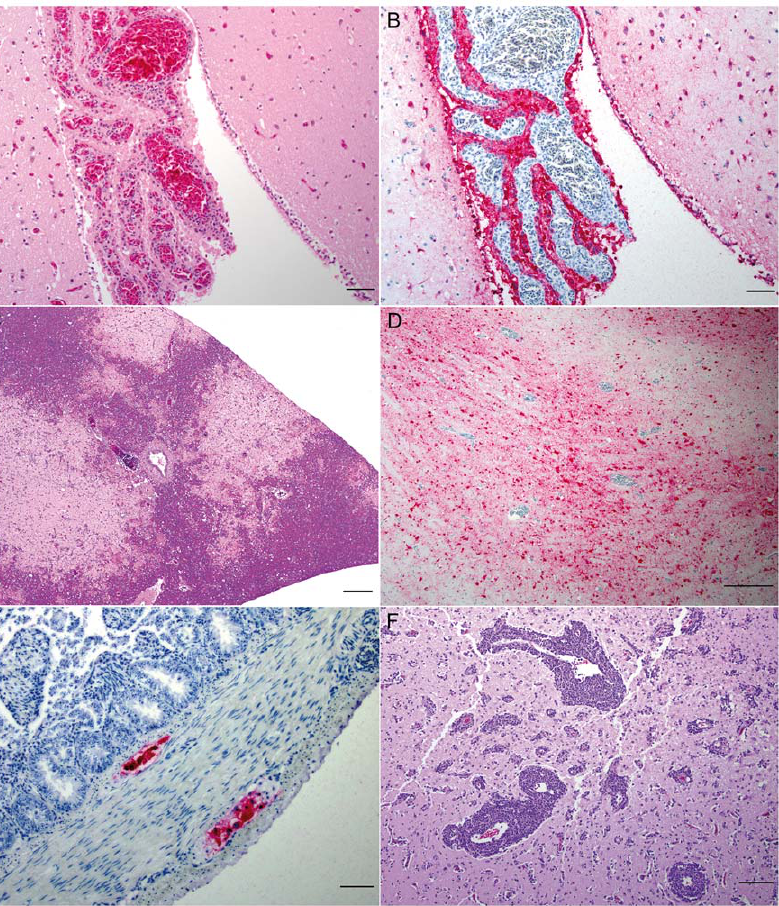
Figure 1. Histopathology and immunohistochemistry of different tissues from wood ducks ( Aixsponsa ) infected with A/whooper swan/Mongolia/244/05 (H5N1). (A) Brain, Choroid Plexus; wood duck that succumbed to Mongolia/05 virus infection. Severe choroiditis characterized by necrosis of epithelial cells of choroid plexus, vasculitis and heterophilic infiltrate. Hematoxylin-eosin staining. Bar 50 m m. (B) Brain, Choroid Plexus; wood duck that succumbed to Mongolia/05 virus infection. Positive staining in epithelial cells of choroid plexus. Immunohistochemical staining: mouse-derived monoclonal antibody (P13C11), biotin-streptavidin alkaline-phosphatase detection method, Fast Red substrate-chromogen, hematoxylin counterstain. Bar 50 m m. (C) Pancreas; wood duck that succumbed to Mongolia/05 virus infection. Severe multifocal to coalescing necrosis of acinar cells. Hematoxylin-eosin staining. Bar 200 m m. (D) Brain, Cerebrum; wood duck that succumbed to Mongolia/05 virus infection. Intense positive immunohistochemical staining of neurons and glial cells. Immunohistochemical staining: mouse-derived monoclonal antibody (P13C11), biotin-streptavidin alkaline-phosphatase detection method, Fast Red substrate-chromogen, hematoxylin counterstain. Bar 200 m m. (E) Small intestine; wood duck that succumbed to Mongolia/05 virus infection. Positive immunohistochemical staining in neurons of myenteric and submucosal plexus. Immunohistochemical staining: mouse-derived monoclonal antibody (P13C11), biotin-streptavidin alkaline-phosphatase detection method, Fast Red substrate-chromogen, hematoxylin counterstain. Bar 50 m m. (F) Brain, Cerebrum; wood duck that survived the Mongolia/05 virus challenge. Severe nonsuppurative encephalitis characterized by marked perivascular cuffing. Hematoxylin-eosin staining. Bar 100 m m.